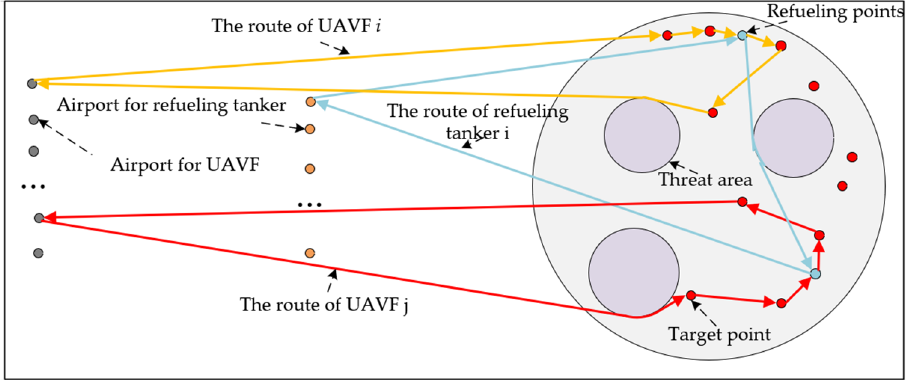
Figure 1. URMFTG scenario.